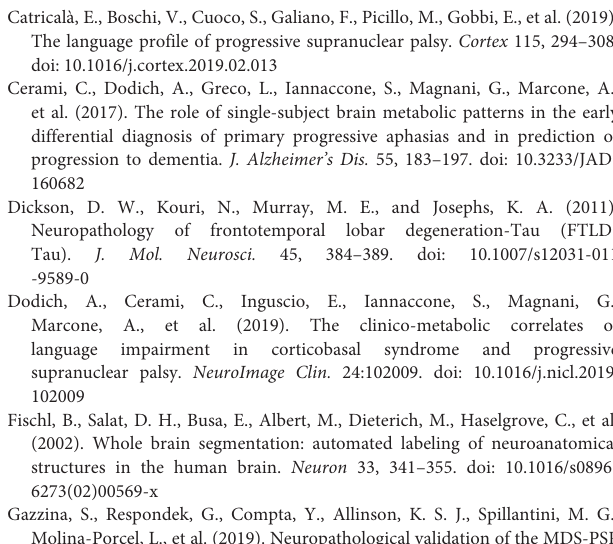
SUPPLEMENTARY TABLE 1 | Comparison between patients who were or were not included in the MRI analysis. SUPPLEMENTARY TABLE 2 | The Structure-LV loading values of each structure (from the Desikan-Killiany atlas) and subcortical volumes, arranged from highest to